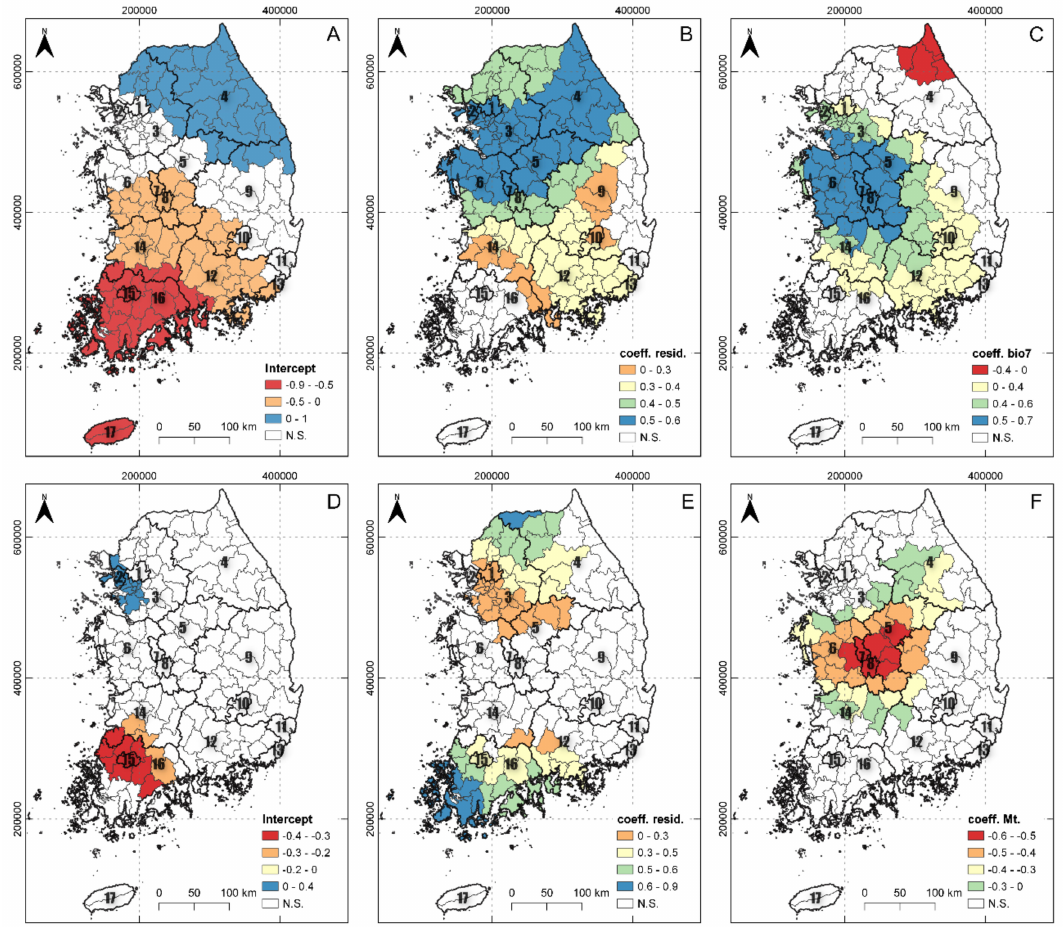
Figure 5. Spatial mapping of the coefficients of the A. pilosus GWR model (intercept ( A ), residential area ( B ), bio7 ( C )) and L. scariola GWR model (intercept ( D ), residential area ( E ), mountain area ( F )). The significance of the local coefficients was determined by pseudo t-values; the regions with t -values between − 1.96 and +1.96 (nonsignificant parameters) are indicated in white; resid.: residential area, bio7: annual temperature range, and Mt.: mountain